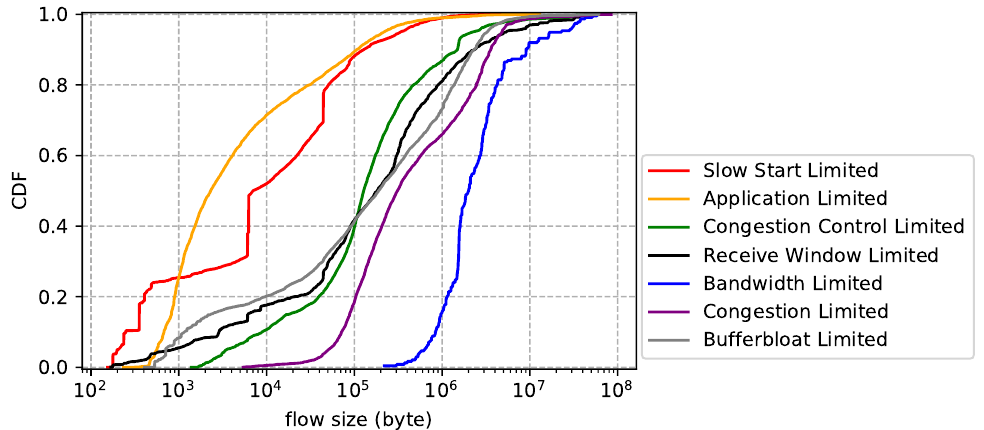
Figure 11. Flow size distribution for each limiting factor (CDN